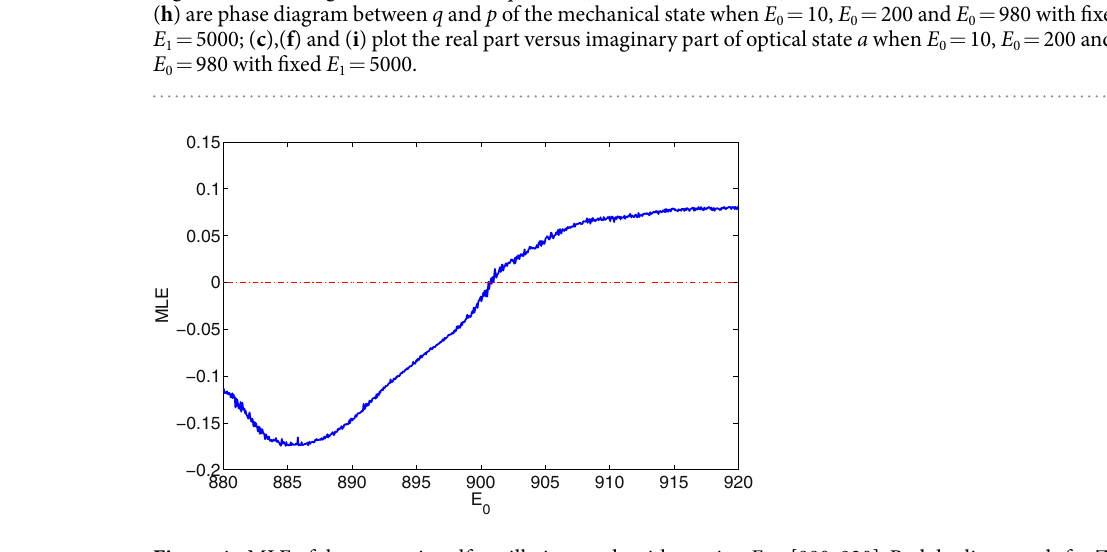
Figure 4. MLE of the system in self-oscillating mode with varying E 0 ∈ [880, 920]; Red dot line stands for Zero- standard